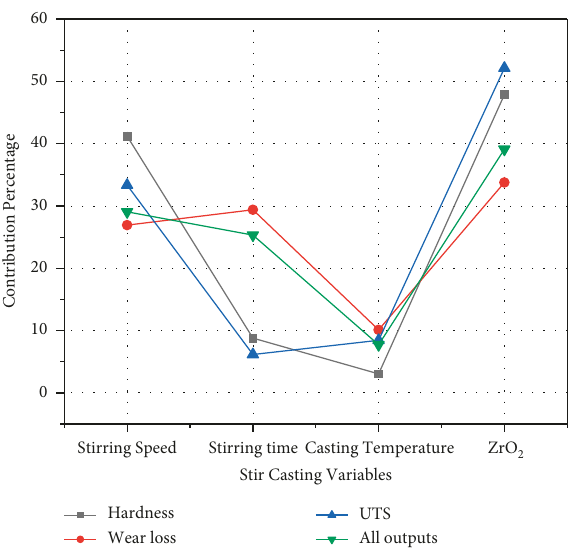
Figure 6: Contribution of parameters on variant responses in